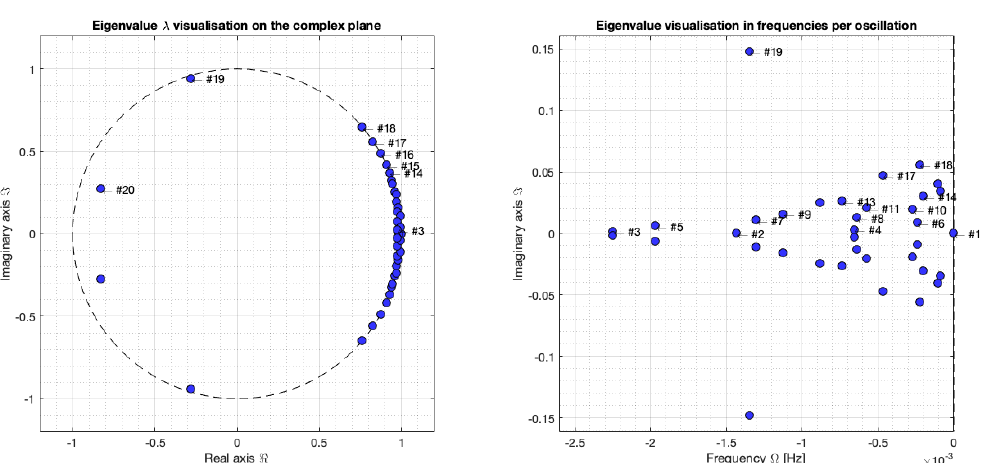
Figure 6. Eigenvalues of the IODMD u . On the left, the discrete time eigenvalues λ on the complex plane are represented relative to the unit circle (dashed line). On the right, the eigenvalues transformed to continuous time are represented. The area where the majority of modes are presented has been zoomed